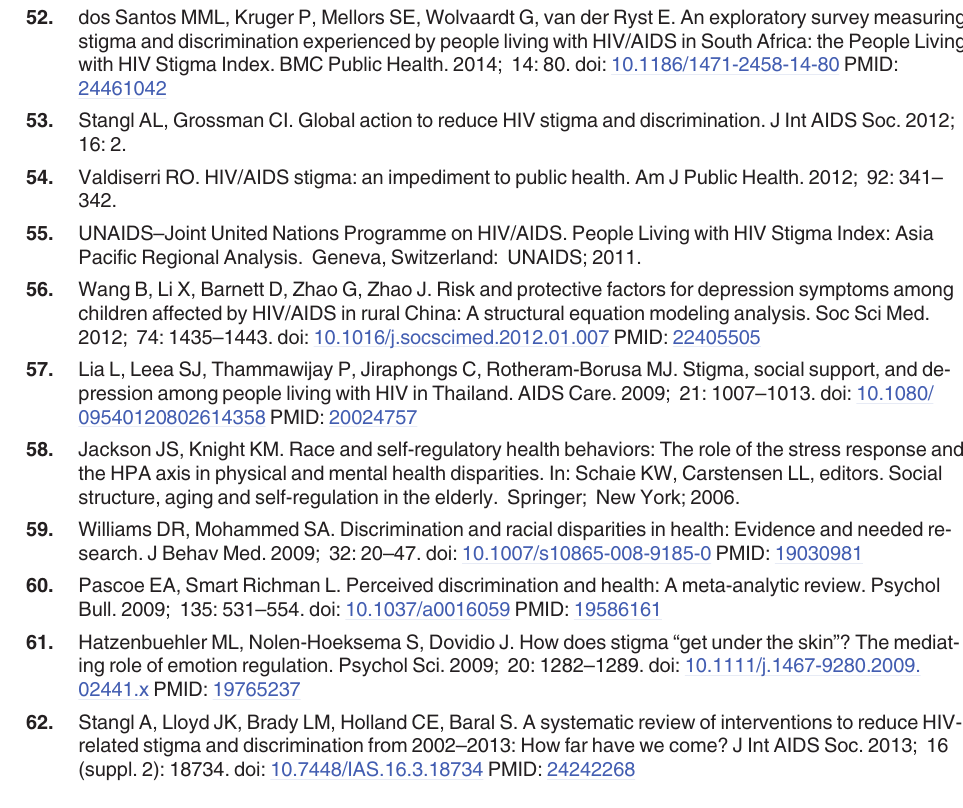
PLOS ONE | DOI:10.1371/journal.pone.0121461 March 25, 2015 16 /